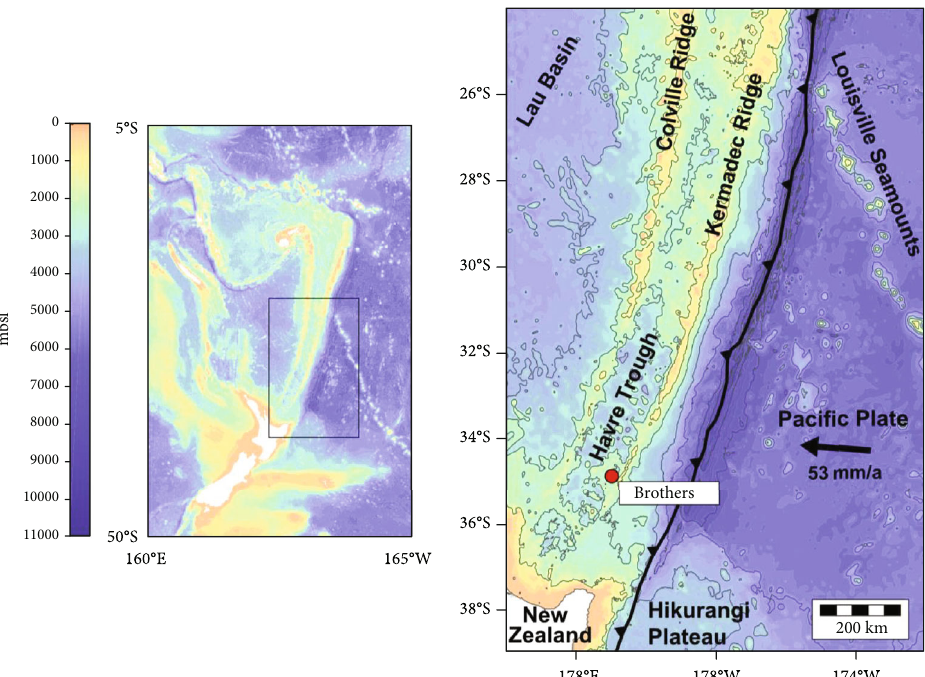
Figure 1: Overview over the South Kermadec arc and location of Brothers volcano. Note: location of subduction zone is given after Bird [45] and the relative plate motion is given after DeMets et al. [46]. Bathymetry data: the GEBCO_2014 Grid, version 20150318, https://www.gebco.net.